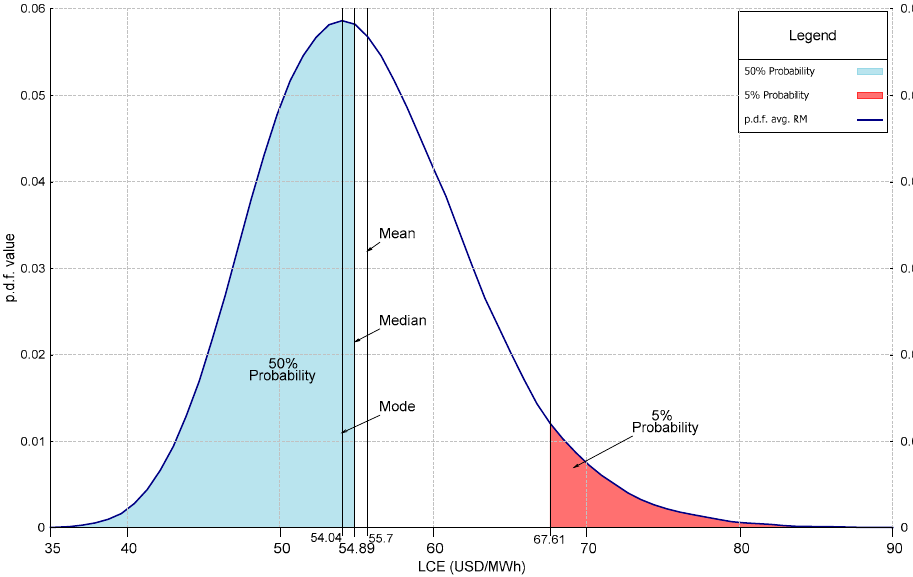
Energies 2019 , 12 , x 7 of 15 Figure 2. IEA roadmap LCOE (USD/MWh): Risk analysis. Probability density function (p.d.f . ). Figure 2. IEA roadmap LCOE (USD / MWh): Risk analysis. Probability density function (p.d.f.).